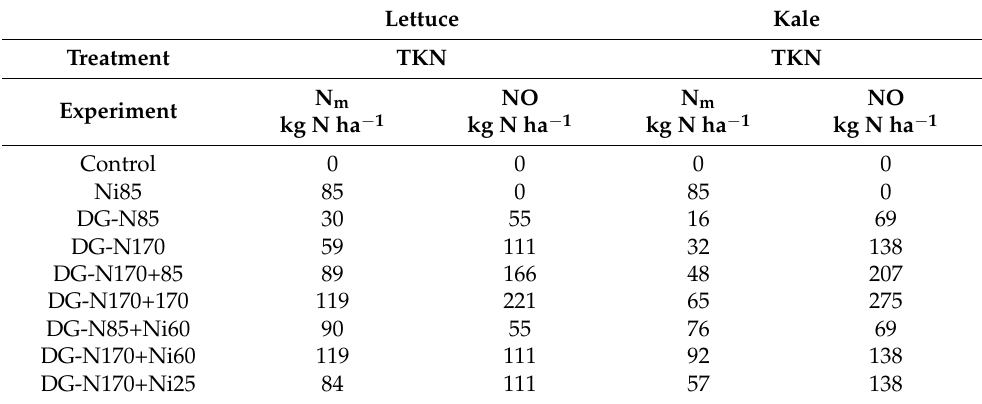
Table 3. Amount of N applied to soil in the different treatments through mineral (N m ) and organic (NO) forms. Lettuce Kale Treatment TKN TKN N m Experiment kg N ha −